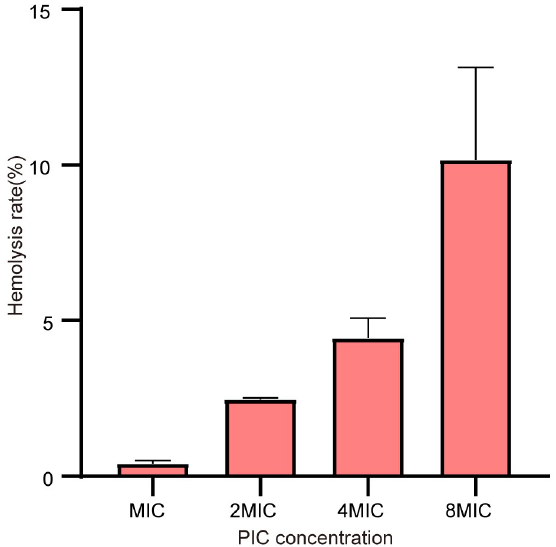
Figure 8. Hemolysis rate of sheep erythrocytes with different concentrations of PIC. n = 3. Results from all experiments are presented as the mean ± SD of three replicates.